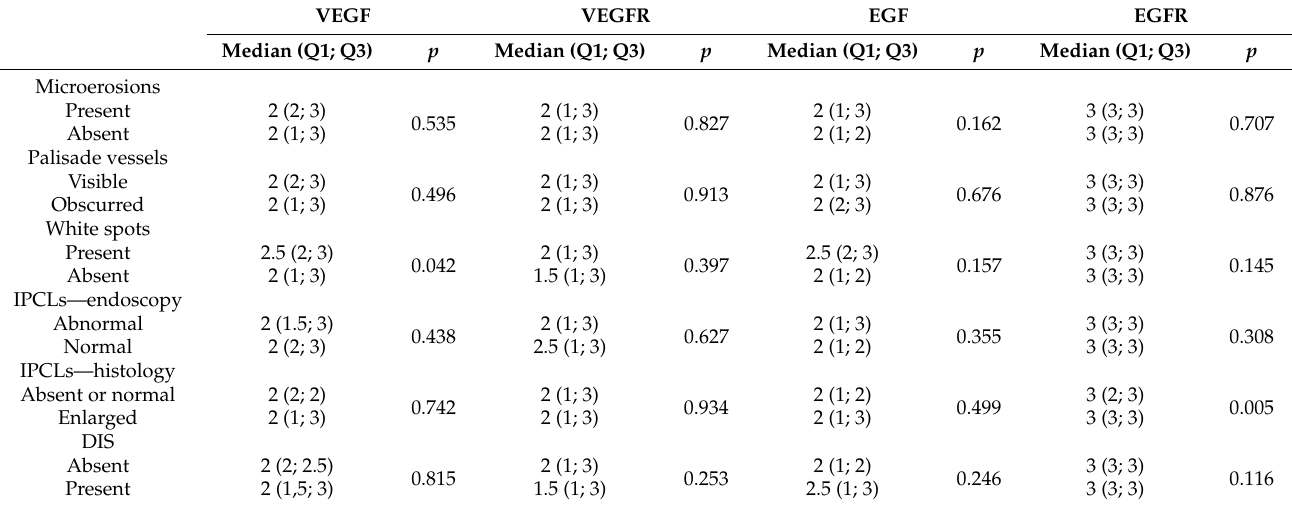
Table 2. Comparison of VEGF, VEGFR, EGF, and EGFR expressions against qualitative endoscopic and histologic features.